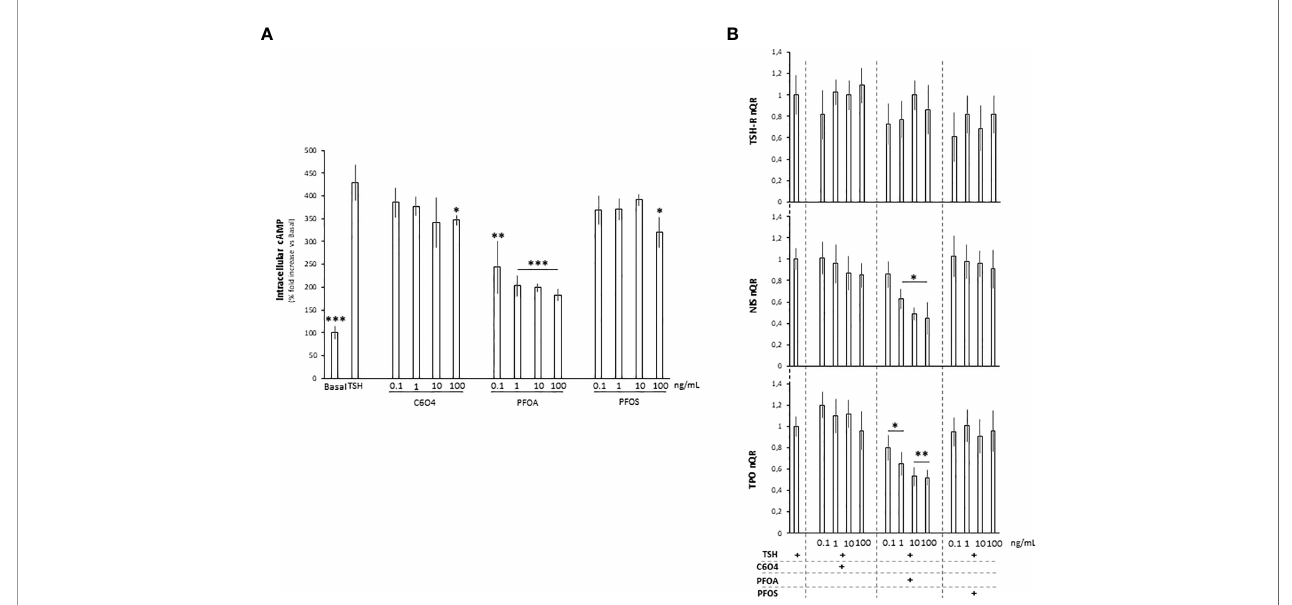
FIGURE 3 | (A) Evaluation of intracellular cAMP levels in FRTL-5 normal rat thyrocyte cell line at basal condition, upon stimulation with 1 mU/ml thyroid stimulating hormone (TSH) or after the exposure for 24 hours to acetic acid, 2,2-di fl uoro-2-((2,2,4,5-tetra fl uoro-5(tri fl uoromethoxy)-1,3-dioxolan-4-yl)oxy)-ammonium salt (1:1) (C6O4), per fl uoro-octanoic acid (PFOA) per fl uoro-octane-sulfonic acid (PFOS), at concentration ranging from 0.1 to 100 ng/mL, followed by stimulation with TSH. Experiments were performed in triplicate and normalized as percentage fold increase on basal control lacking TSH stimulus and exposure to per fl uoroalkyl substances (CTRL). Data are reported as mean values ± standard deviation Signi fi cance: *P < 0.05, **P < 0.01, ***P < 0.001 vs unexposed cells stimulated with TSH. (B) Evaluation of TSH-receptor (TSH-R), sodium-iodide symporter (NIS) and thyroperoxidase (TPO) gene expression FRTL-5 cell at different combinations of exposure to C6O4, PFOA and PFOS, at concentration ranging from 0.1 to 100 ng/mL, and upon stimulation with TSH. Experiments were performed in triplicate and normalized on cell stimulated with TSH. Signi fi cance: *P < 0.05, **P < 0.01, ***P < 0.001 vs